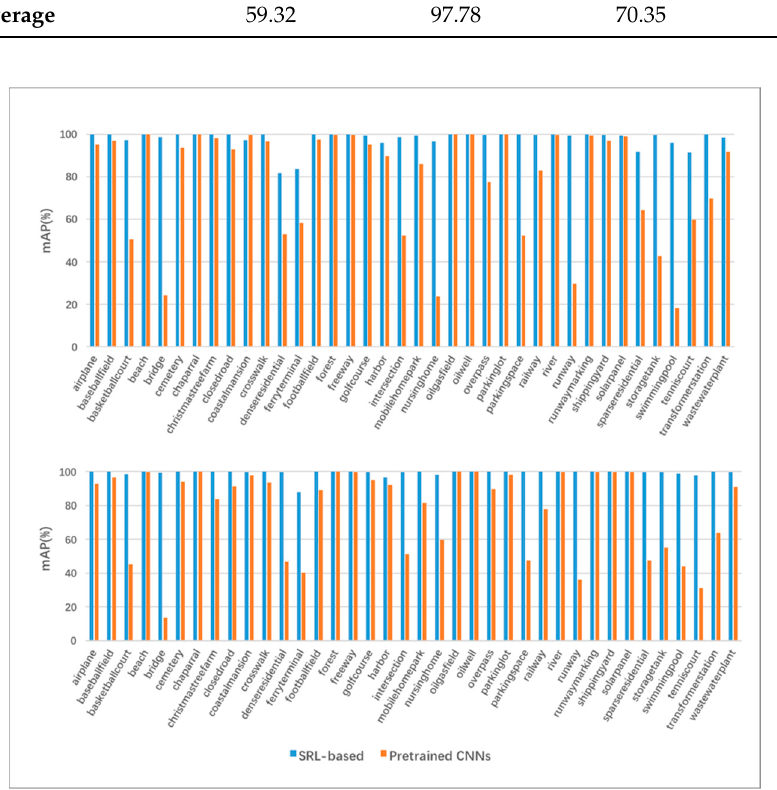
Figure 10. Evaluation of mAP is performed with VGG16 (top) and ResNet50 (bottom) on per-class in the PatternNet datasets trained with different features.